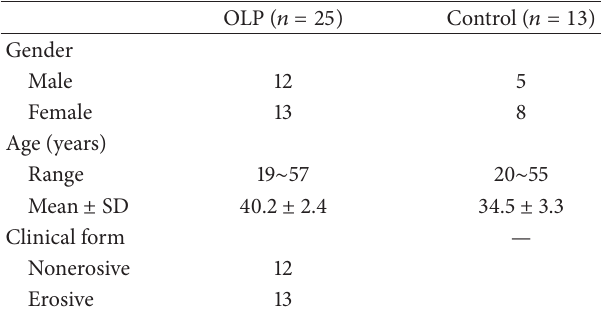
Table 1: Clinical features of the